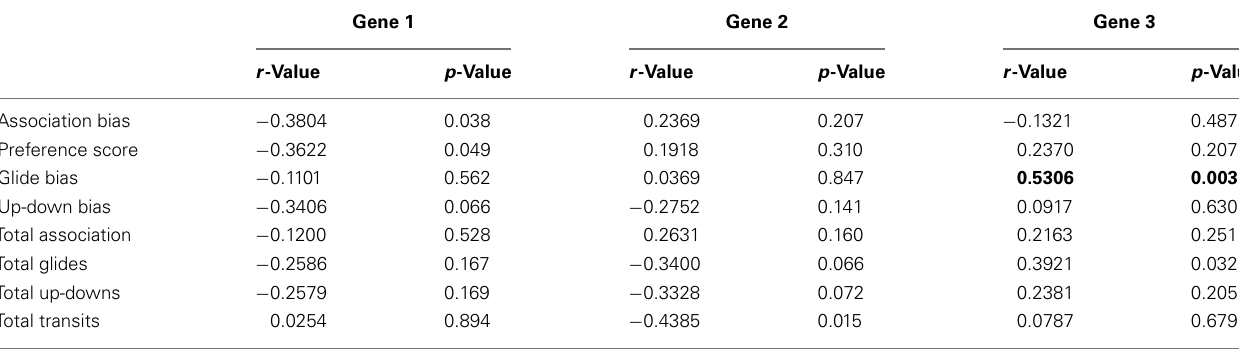
Table 3 | Pearson’s correlations between individual input behaviors and Gene MDA